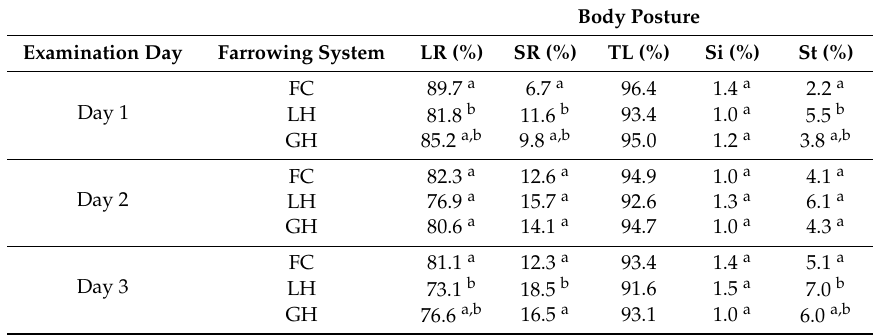
Table 5. Mean percentage of sows’ body postures on di ff erent examination days. Farrowing system: FC = pen with farrowing crate; LH = single loose housing pen; GH = single loose housing pen of the